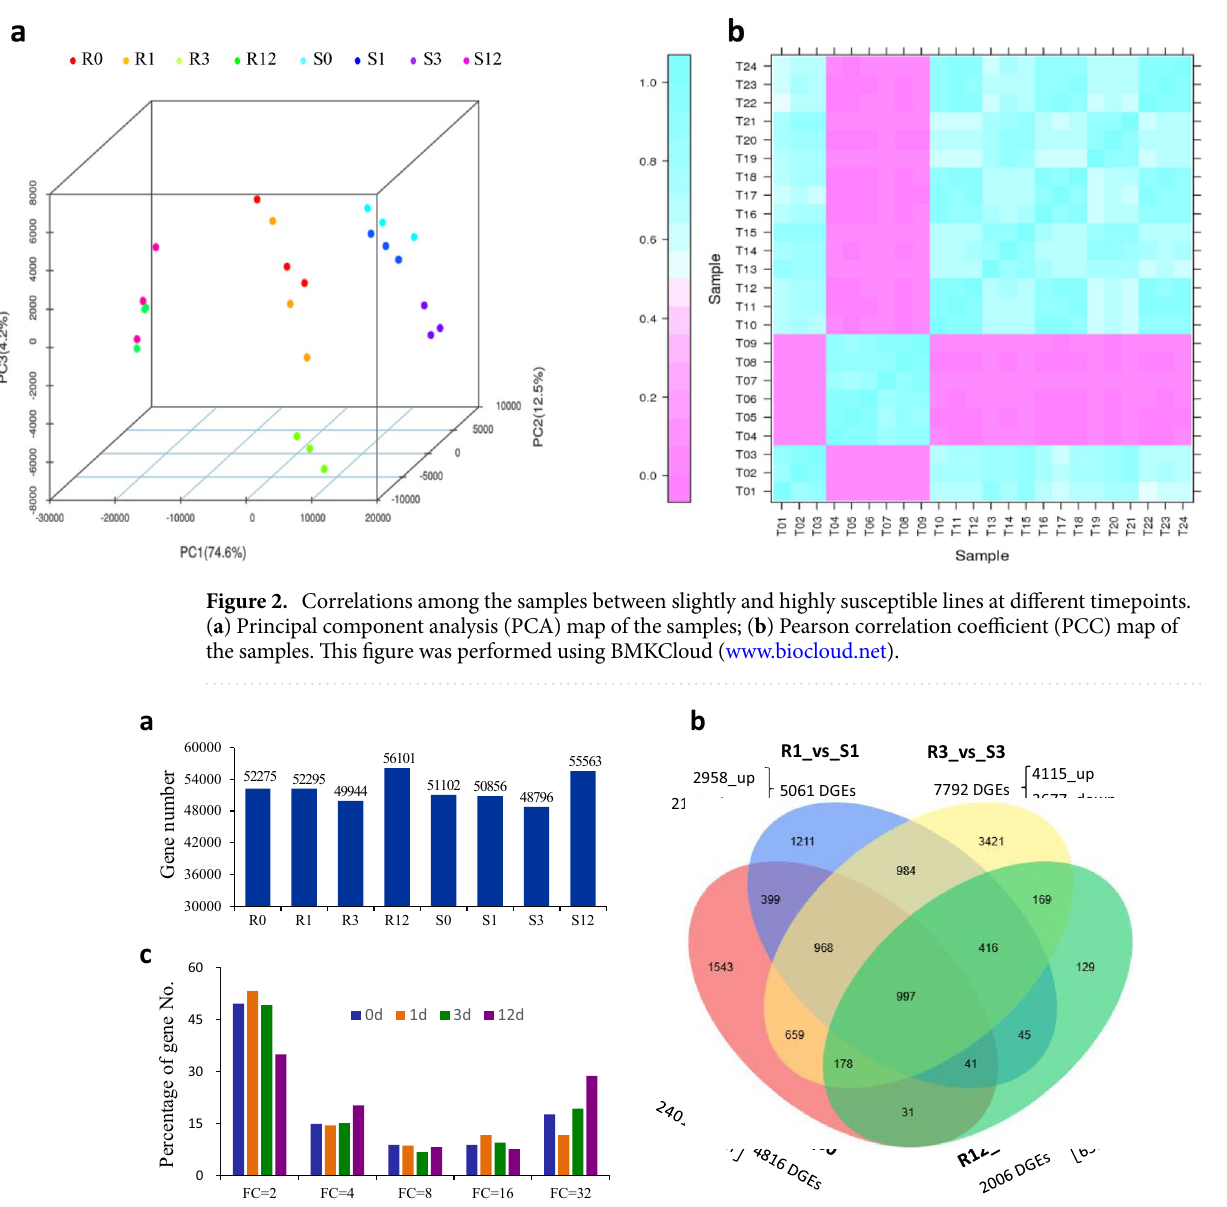
Figure 3. The differentially expressed genes (DEG) profiles. ( a ) Histogram of the gene numbers in the eight samples; ( b ) Venn diagram of DEG numbers in eight samples; ( c ) DEG numbers with different fold changes. 0, 1, 3, and 12 indicated the different days after inoculation. R and S are the slightly susceptible (SN4143) and highly susceptible (PZSCL6) line,